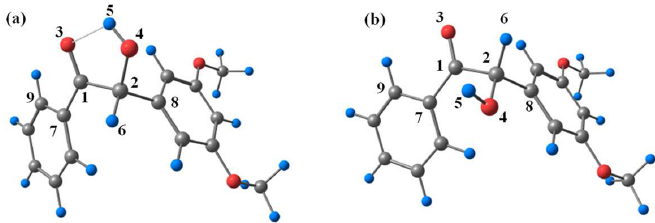
Figure 8. Optimized geometries of ( a ) cis -DMB and ( b ) trans -DMB at ground state.